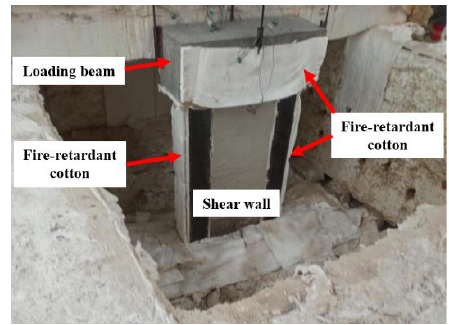
Figure 4. Fire protection treatment of specimen.